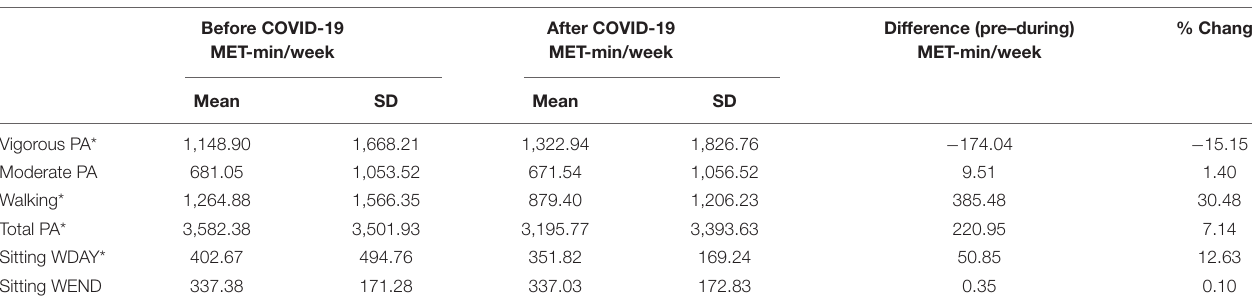
TABLE 3 | Physical activity and sedentary behaviors of female students before and during COVID-19. Before COVID-19 MET-min/week